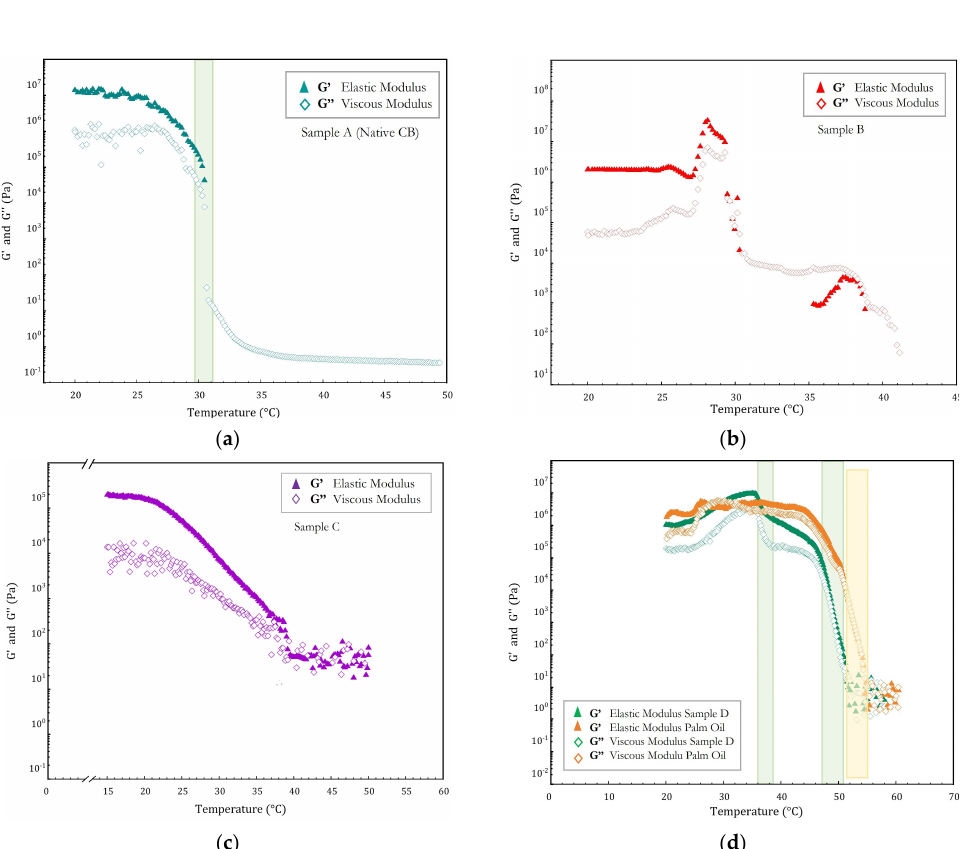
Figure 4. Time cure test ( a ) in the range 20–50 °C of native CB (sample A), of modified ( b ) sample B, and ( c ) sample C in the temperature range 15–50 °C. ( d ) Comparison of modified samples D (in green) with that of palm oil (PO, in orange) in the range 20–60 °C. Vertical lines define the temperature transition region.